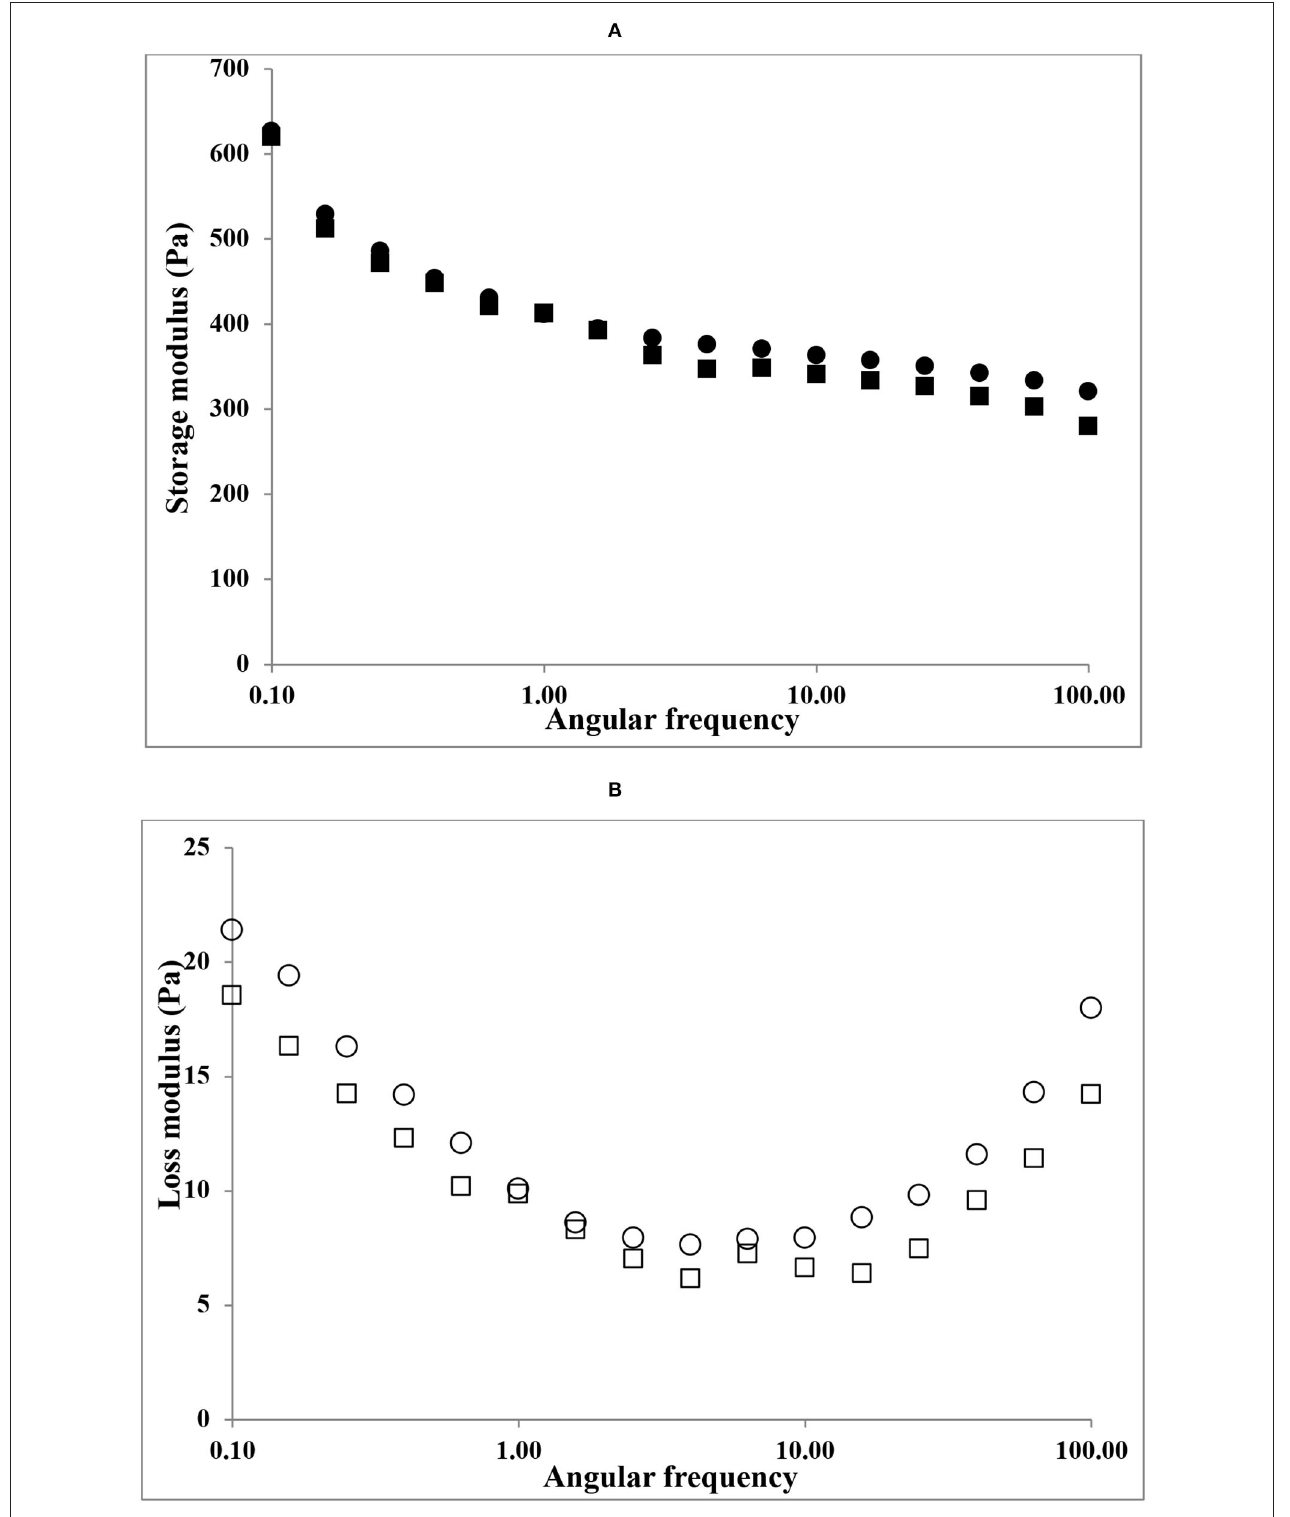
FIGURE 4 | Frequency sweep plots of gelatin samples. (A) storage modulus (G’) of HAD ( (cid:4) ), FD ( • ), and (B) loss modulus (G”) of HAD ( (cid:3) ) and FD ( (cid:13) ) samples.